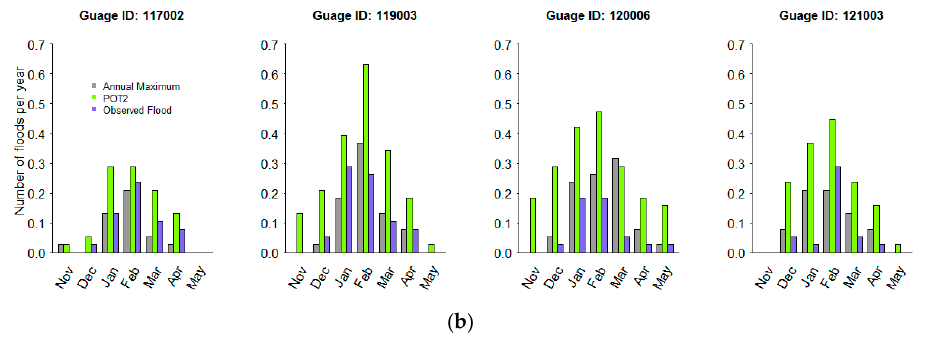
Figure 10. Monthly flood frequency for the AM and POT series compared to the BF series for ( a ) wet-tropical and ( b ) dry-tropical catchments.